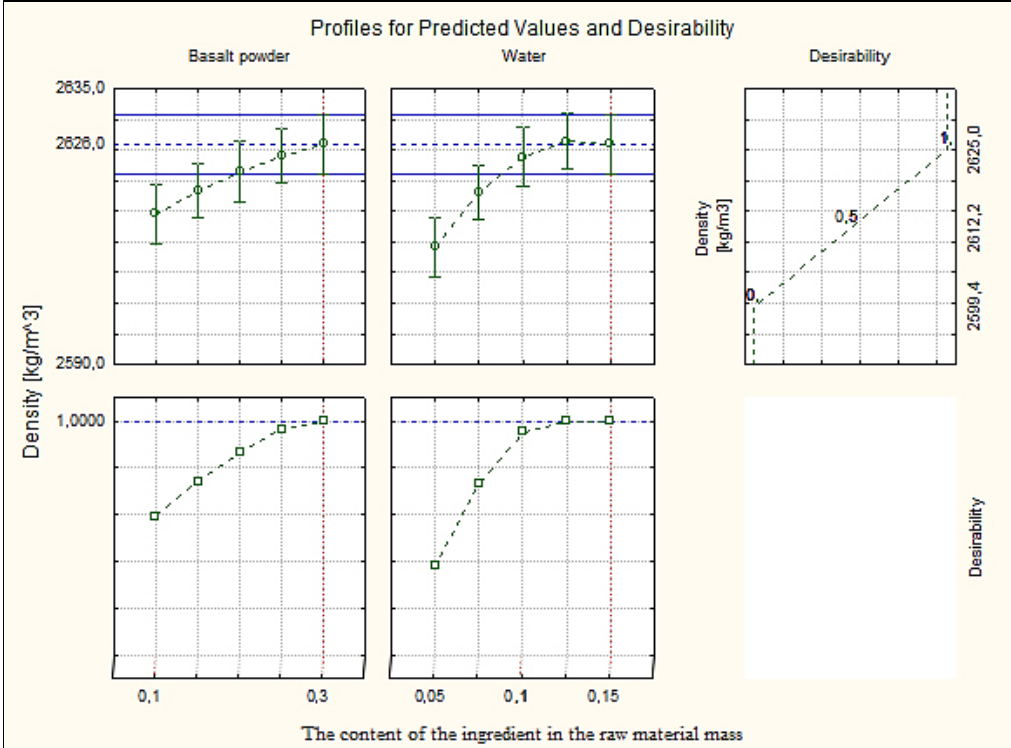
Figure 18. Profiles for predicted value and desirability for density.